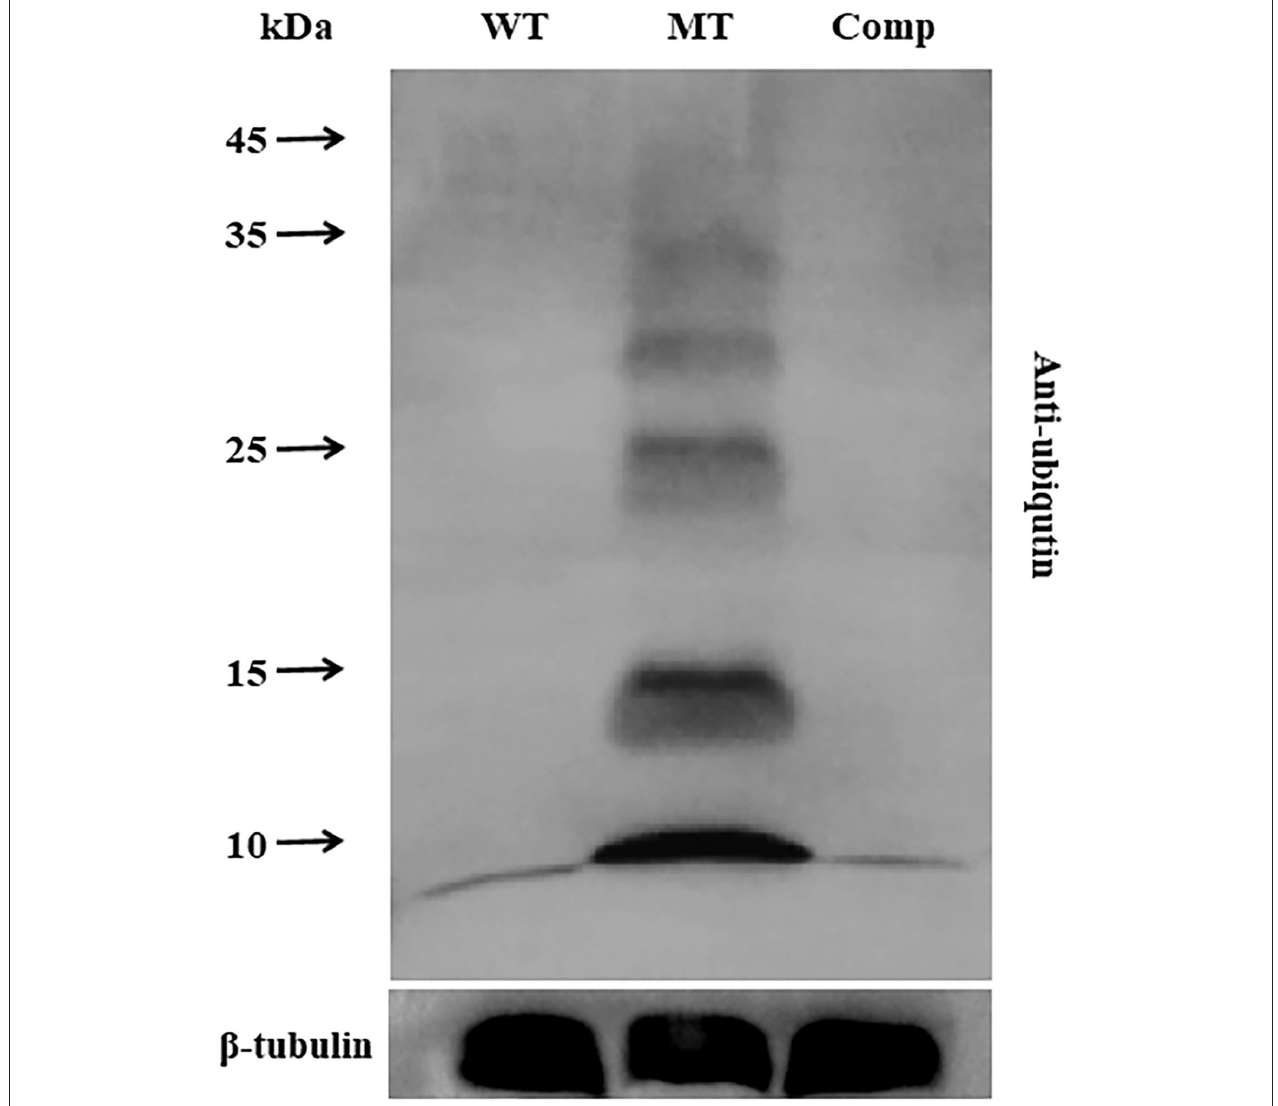
FIGURE 5 | Effect of MrUbp14 disruption on protein ubiquitination levels. Total proteins were obtained from the mycelia (cultured for 2 days on PDA) of each strain. Protein extracts were separated by 10% sodium dodecyl-sulfate polyacrylamide gel electrophoresis (SDS-PAGE) and then probed with anti-ubiquitin antibodies (PTM bio) to determine total ubiquitin levels. The ubiquitination levels of total proteins from different strains were compared using western blot analysis. An anti-tubulin antibody was used as an internal control. Disruption of MrUbp14 leads to a large increase in the ubiquitination levels of total